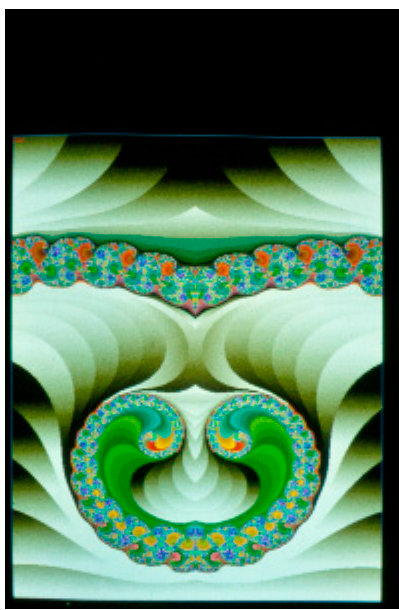
Figure 19. A screenshot, apparently derived from the Mandelbrot set, manipulated in a paintbox program, and captured on slide film by Ostoja. Published with permission. Image courtesy of the State Library of South Australia. SLSA: PRG919/22/1208.